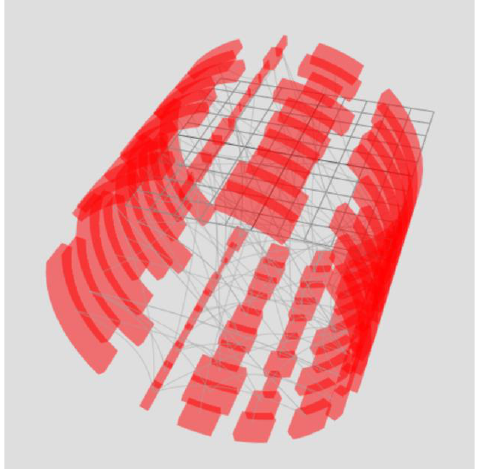
Figure 13. Stacked chord diagram. Each chart represents one-time slice. The arrangement of arc elements of the ring one after another provides information about the change in the parameter over time by analogy with a flowchart.